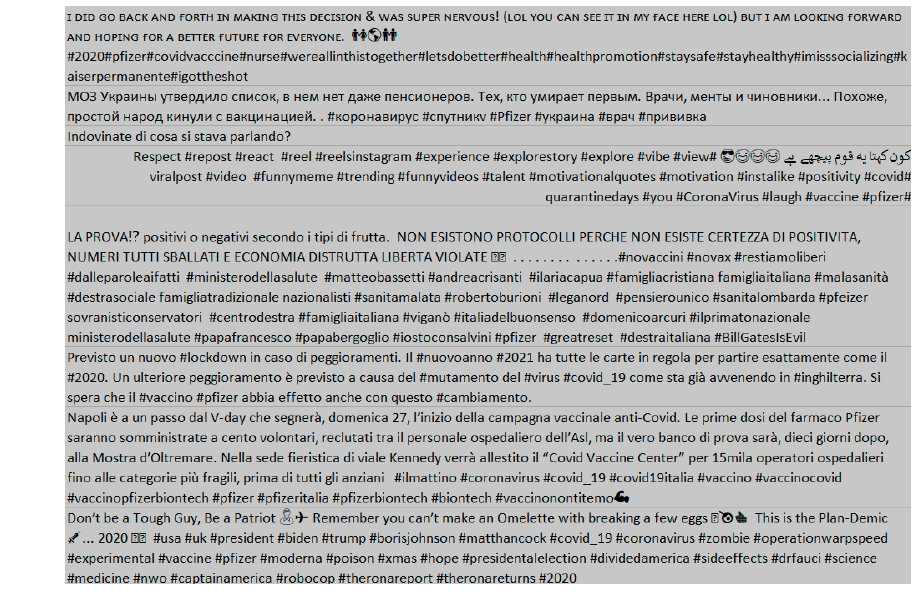
Figure 8. An excerpt from users’ posts.